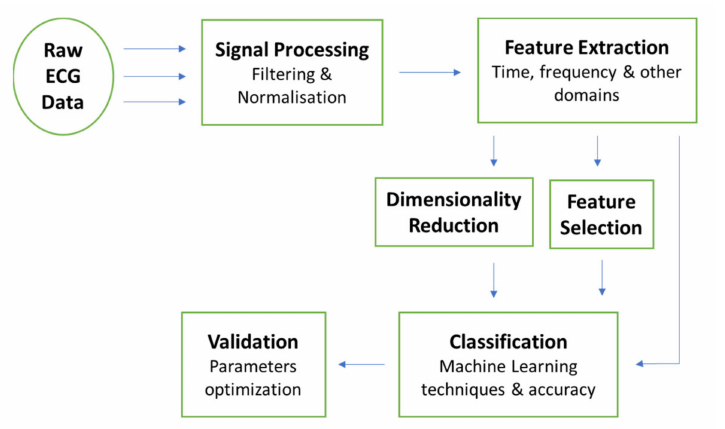
Figure 9. General methods for an ECG-based emotion recognition system using machine